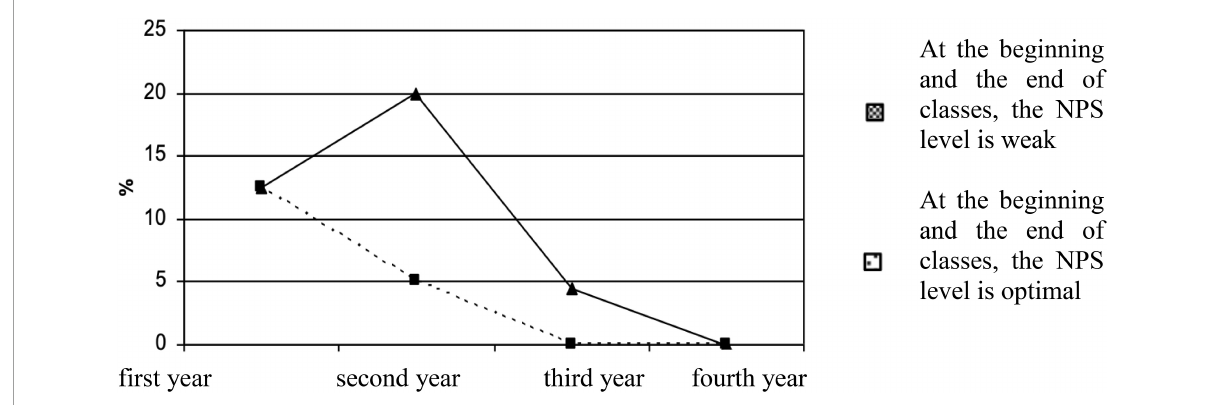
FIGURE5 Frequency of occurrence of different dynamics patterns in the level of a neuropsychic strain of psychology students in the first age subgroup from the beginning to the end of classes (in %).